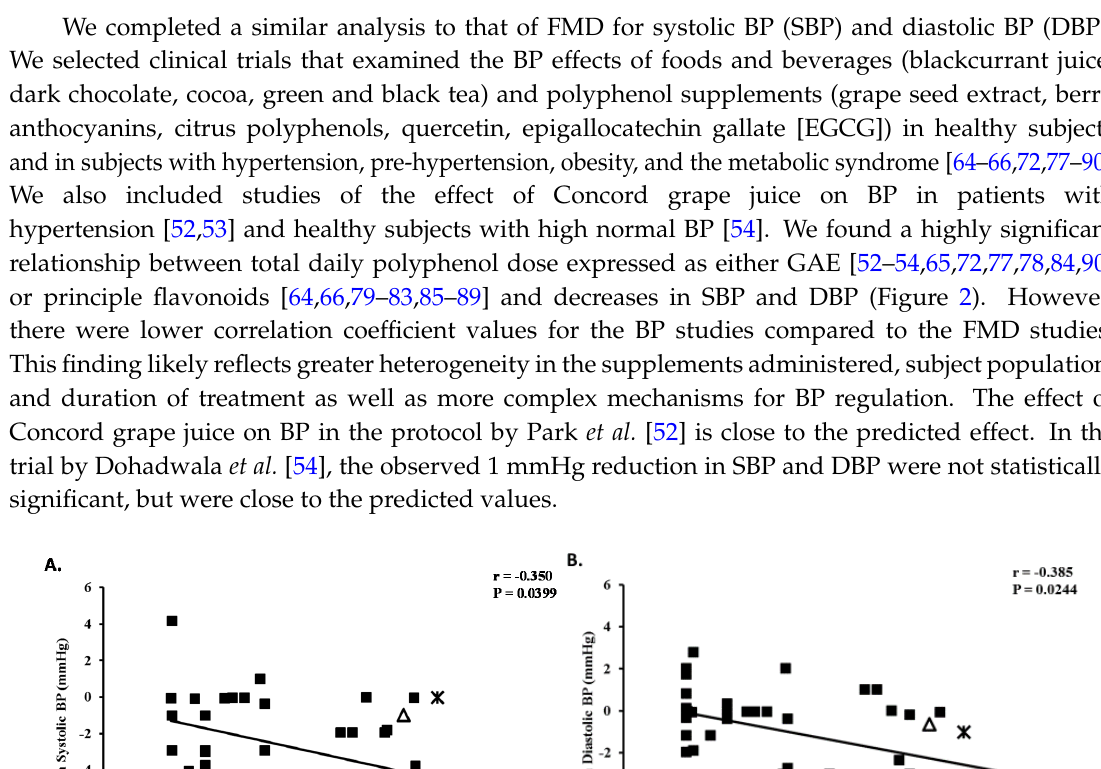
Figure 2. Dose ‐ response for polyphenol ‐ containing foods and beverages on systolic blood pressure ( A ) and diastolic blood pressure ( B ). Regression equations: Change in Systolic BP = (Total polyphenols/day × − 0.00294) − 1.2585. Change in Diastolic BP = (Total polyphenols/day × − 0.00205) − 0.2279. Concord grape juice: